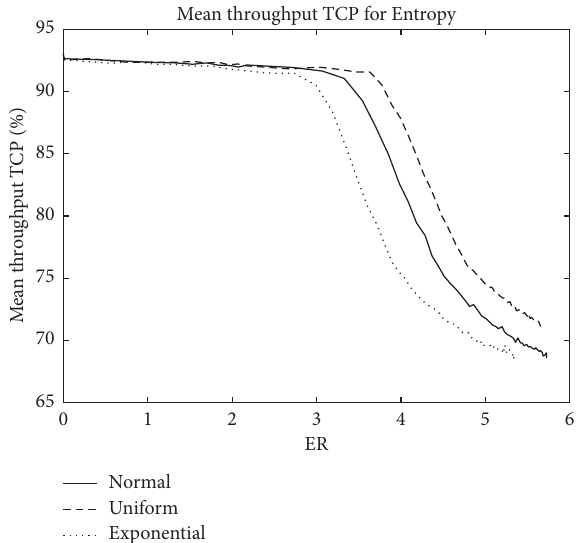
Figure 7: Throughput TCP for the values of E